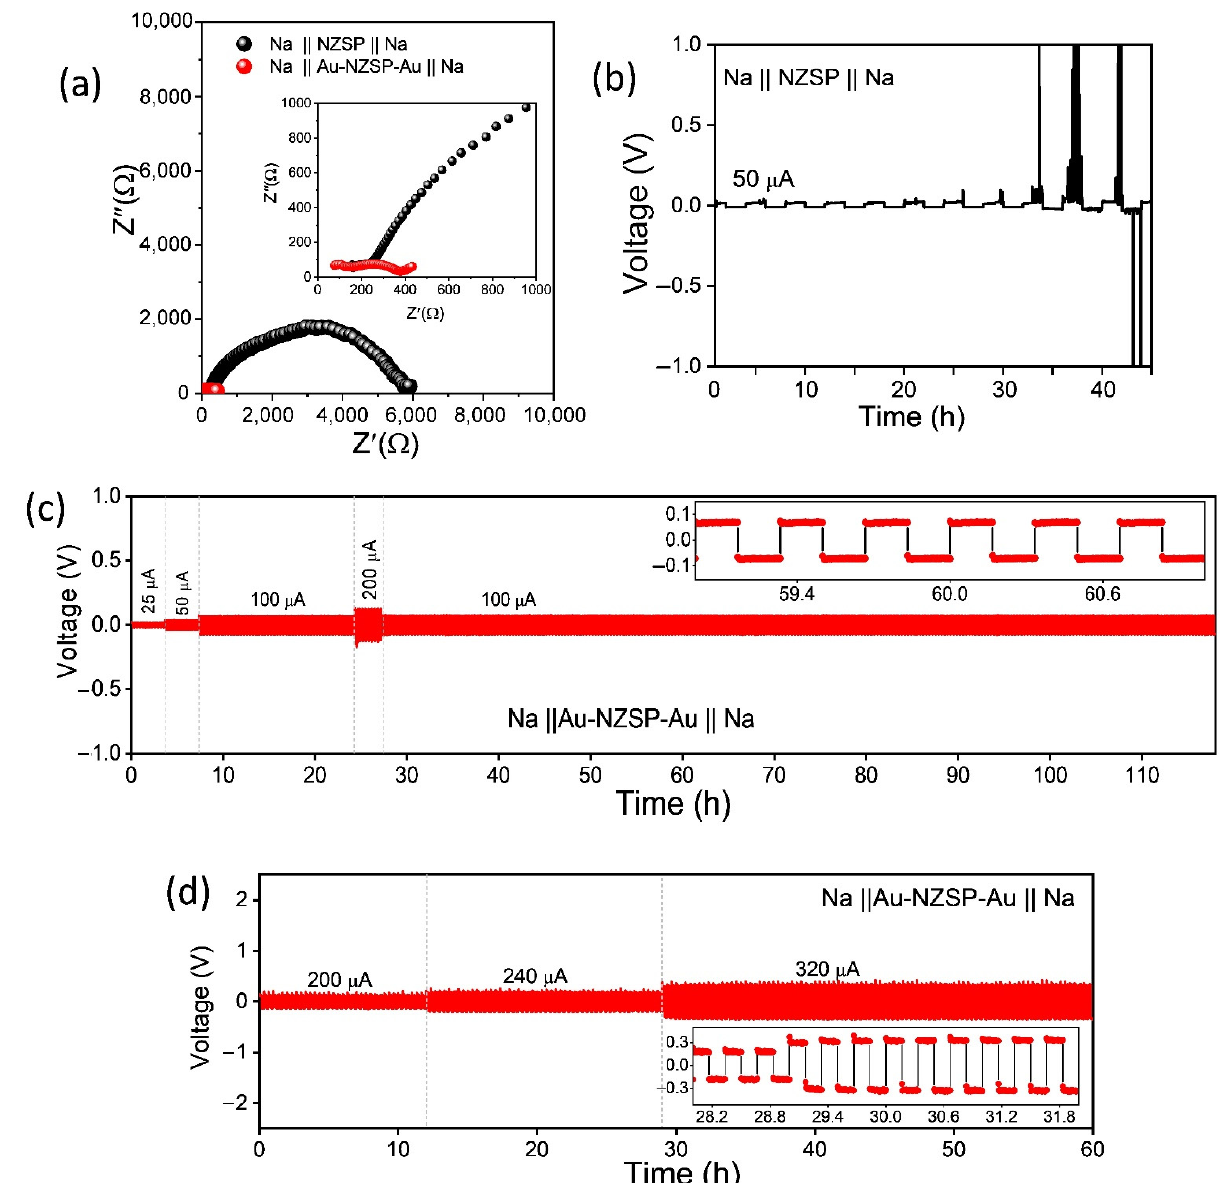
Figure 4. ( a ) Impedance plot of the symmetric cells Na ||NZSP|| Na and Na ||Au-NZSP-Au|| Na; ( b ) sodium-stripping/plating profile of Na ||NZSP|| Na at 50 µA cm − 2 ; ( c ) sodium-stripping/plating of Na ||Au-NZSP-Au|| Na with an increasing current density ranging between 25 and 200 µA cm − 2 ; ( d ) voltage profile at higher current densities of 200, 240, and 320 µA cm − 2 for Na ||Au-NZSP-Au|| Na. All the measurements were performed at 25 °C.